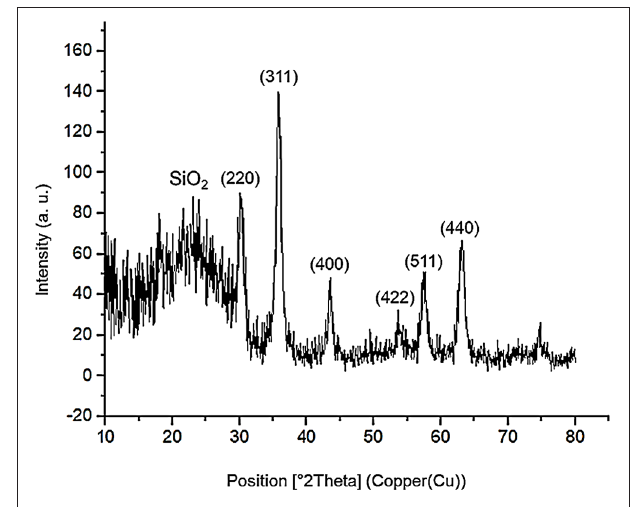
FIGURE 11 | PXRD pattern of the recovered Fe 3 O 4 @OS-SO 3 H nanocatalyst.